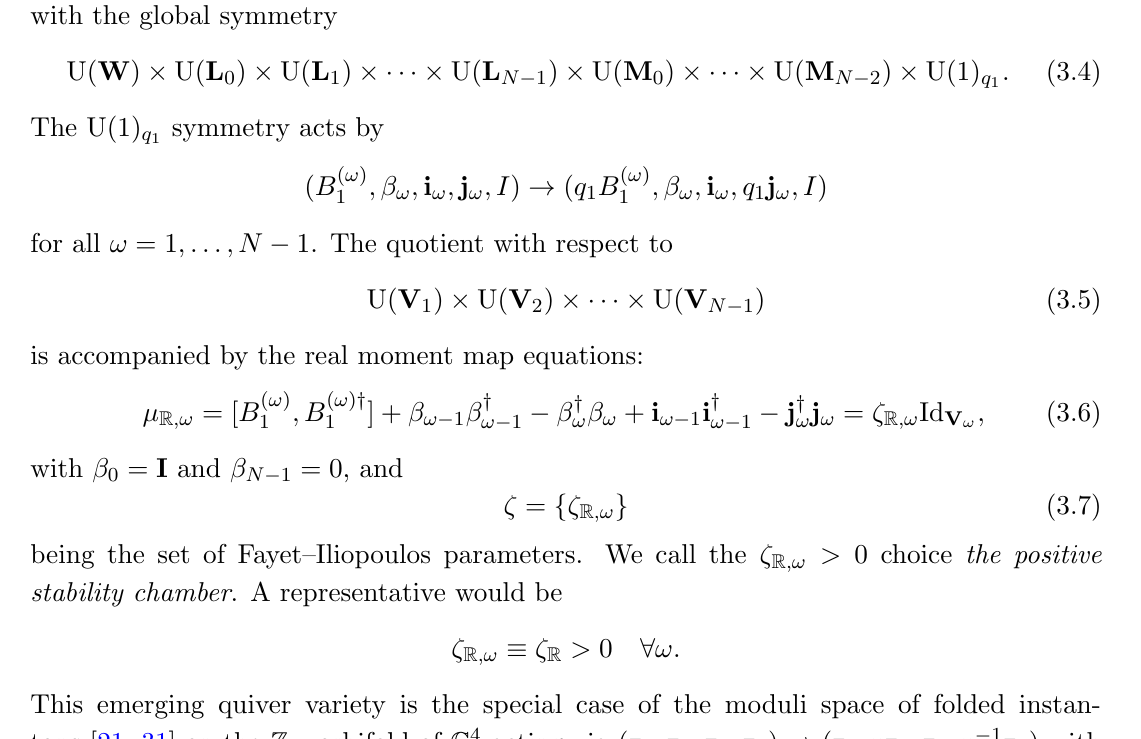
Figure 2 . The quiver emerging from the V ! dependence of the normalized vev (cid:9) a . with the global